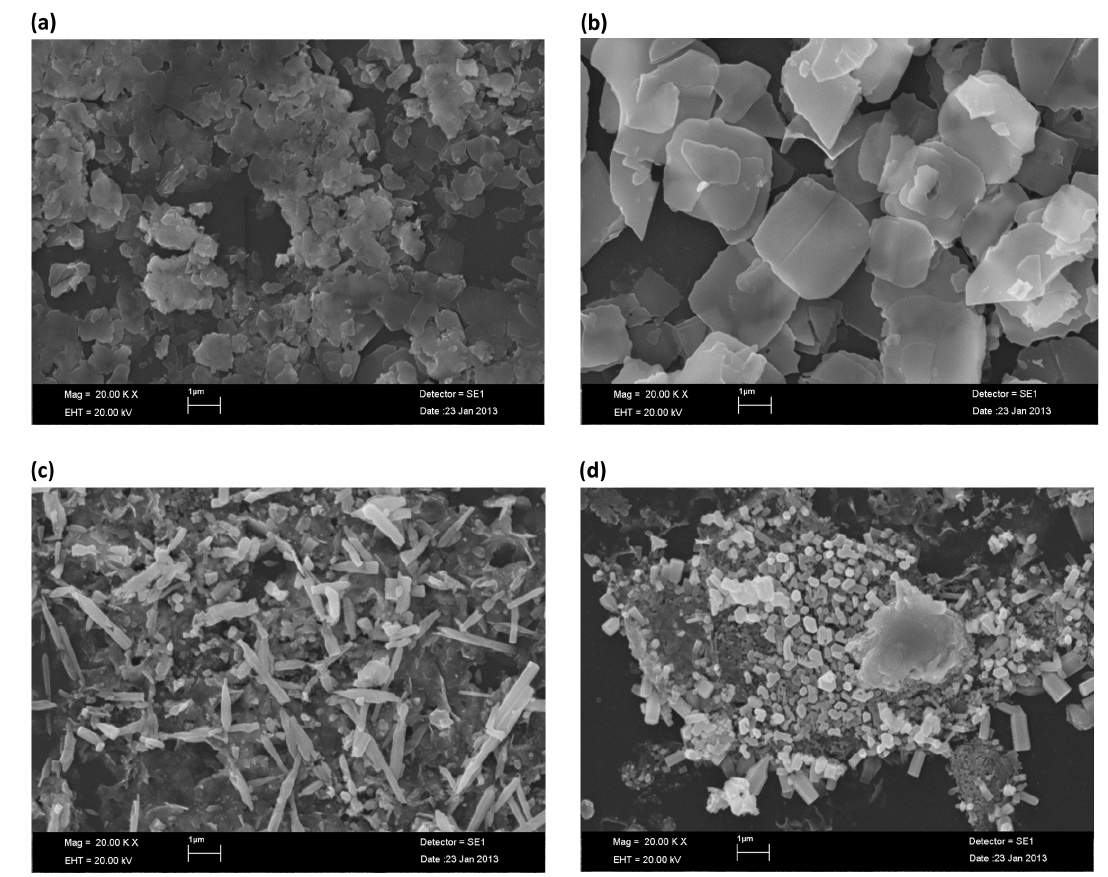
Fig. 7. SEM images of the films at different concentrations (a) 10 -4 M, (b) 10 -3 M, (c) 10 -2 M, (d) 10 -1